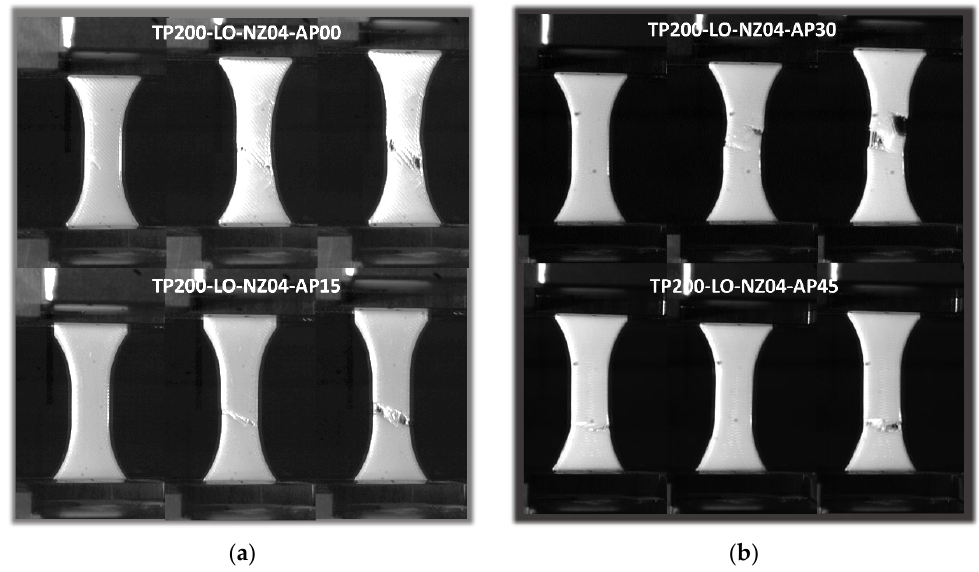
Figure 12. Effect of horizontal orientation (LO) on tensile behaviour of PLC for different in-plane printing angles: ( a , b ) close-up view of filament and 3D-printed PLC sample.